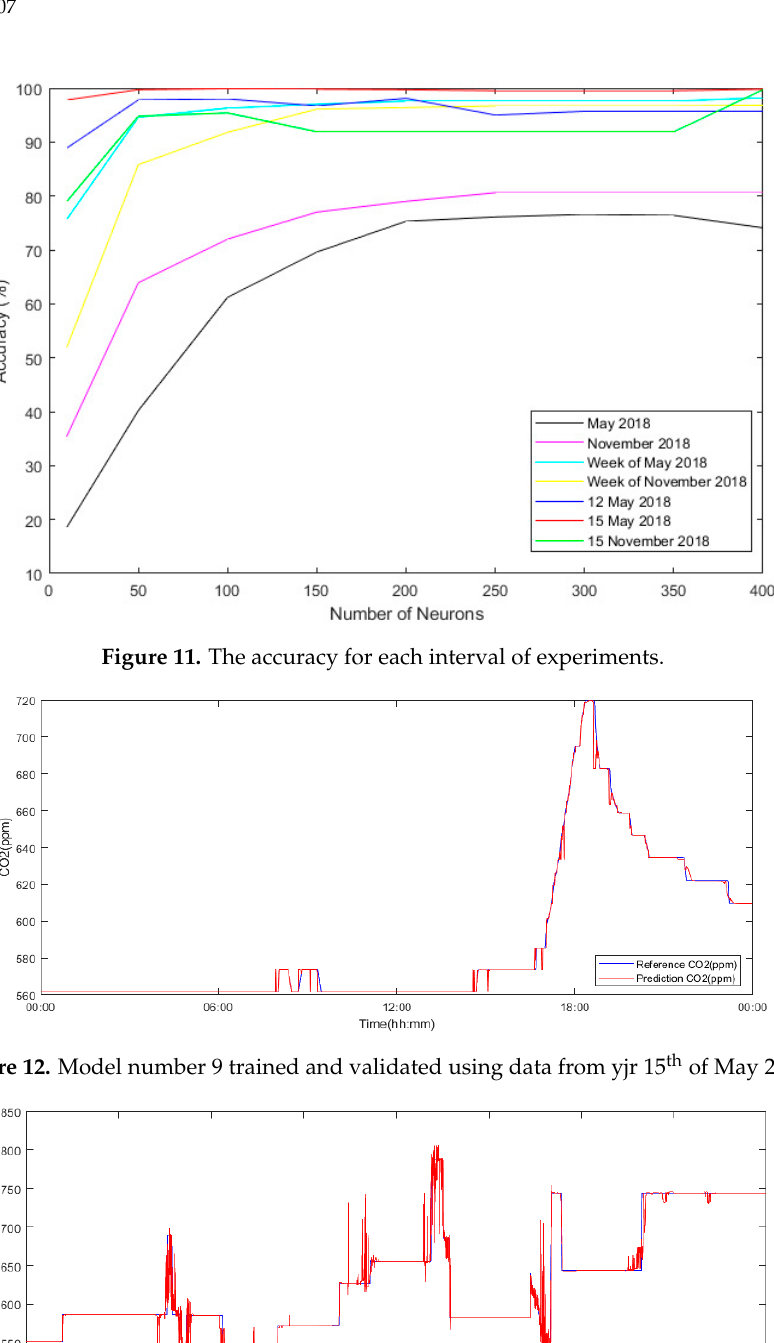
Figure 14. Model number 3 trained and validated using data from the interval of 12 th of May 2018. 4.2.5. IoT Implementation with Watson Studio SW Tool The data streams created in the IBM SPSS Modelers can be stored as a file (“.str” format). The IBM Watson Studio allows the user to import the developed data stream simply by uploading the stored files. This allows the data streams that were originally developed in the IBM SPSS Modeler to take advantage of cloud computing, cloud storage and the possibility of near-real-time streaming. As it was explained earlier, model number 9 (with 400 neurons) trained with the data from 15th of May was selected as the best overall result of this experiment. Specifically, this model showed high accuracy, high linear correlation, low MAE and MSE errors. Therefore, it was uploaded to Watson studio. Figure 15 shows the streamed developed in SPSS in Watson studio for near-real-time training (Excel files were replaced with assets on the cloud). Figure 16 shows a data flow stream in Watson that includes model 9 trained with data from the 15 th of May for near real-time prediction. Figure 15. Watson Studio with the data stream developed in IBM SPSS Modeler.